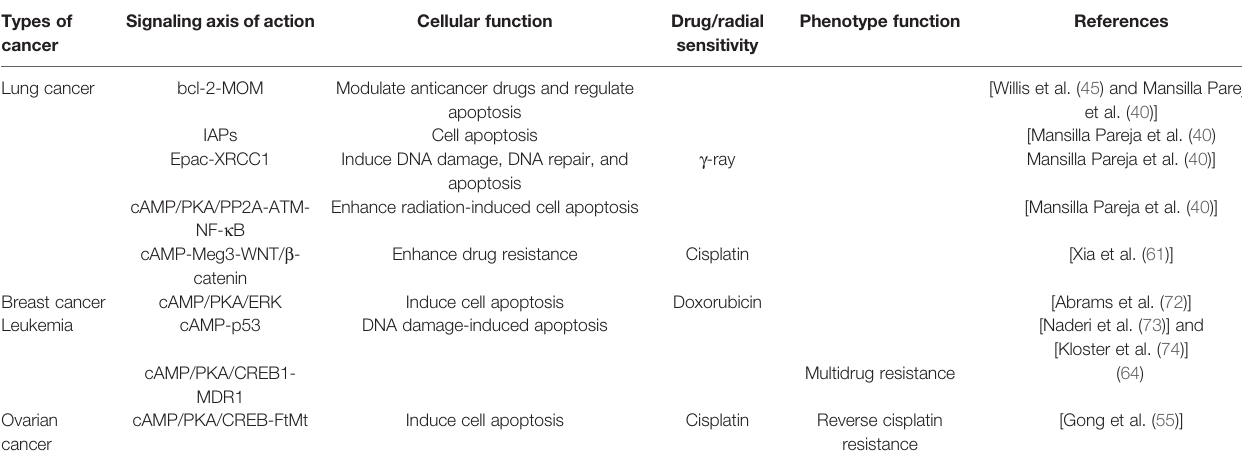
TABLE 3 | Role of adenylate cyclase-related pathways in cancer drug or radiotherapy